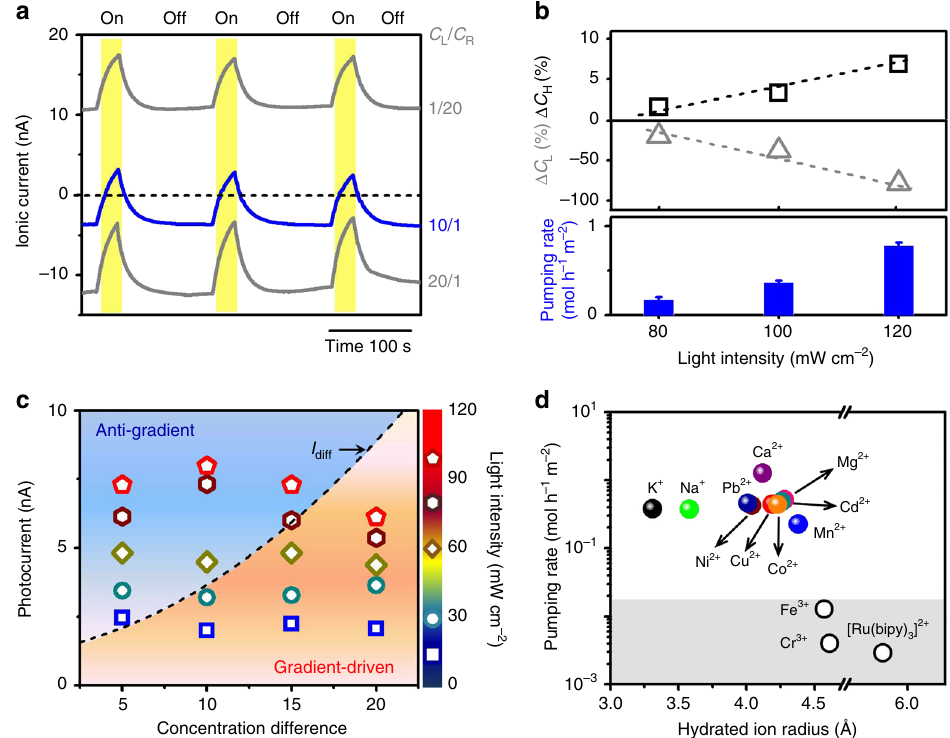
Fig. 2 Anti-gradient ion transport. a Time traces of photocurrent under concentration gradient. Light illumination (100 mW cm − 2 ) was on the left 1/3 of the GOM. When C L / C R = 10/1, the ionic current goes across the zero line, and further increases in the reverse direction, showing anti-gradient ion transport. But when the concentration gradient was too high (e.g., C L / C R = 20/1) or in the reverse direction ( C L / C R = 1/20), no ionic current reversion was found. b Photo-induced variations in K + concentration and corresponding ion pumping rates measured by ICP-OES. After light illumination for 180 s, C high further arises, while C low falls down, showing anti-gradient ion transport. Error bars denote standard deviation. c Photocurrent against different concentration gradients and with varied light intensities. The dashed line indicates the diffusion current ( I diff ). When the magnitude of the photocurrent is larger than I diff , anti-gradient ion transport can be found. Otherwise, the ion transport is governed by the concentration gradient. d Pumping rates for different ionic species against 10-fold concentration gradient. The gray area indicates the below-detection limit of the measurements. The concentration change for Fe 3 + , Cr 3 + , [Ru(bipy) 3 ] 2 + was not effectively